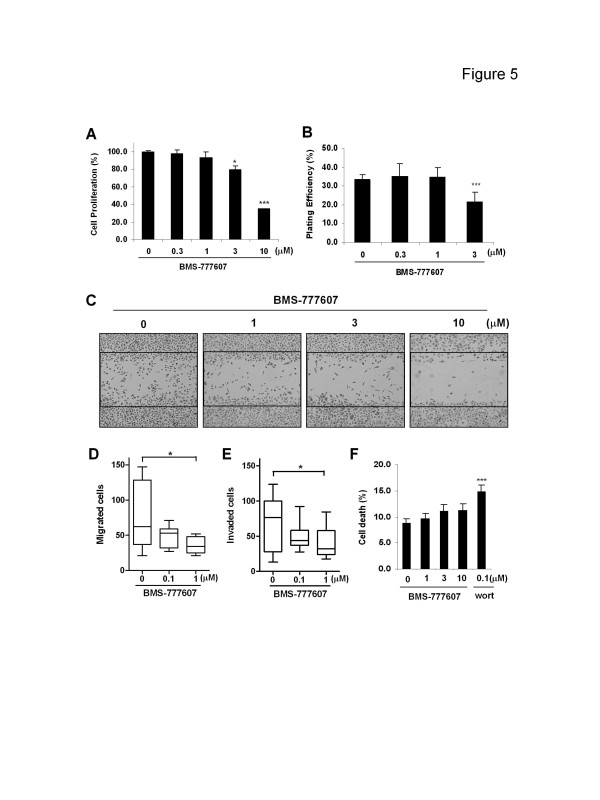
Effect of Met inhibitor BMS-777607 on PC-3 cell functions PC-3 cells were treated with indicated doses of BMS-777607 for 4 days (A), 14 days (B), 1 day (C), 2 days (D, E) and 3 days (F), for the detection of cell growth (MTT assay, A), clonogenicity (colony formation assay, B), cell motility [“wound-healing” assay, C (magnification, ×5)], migration (transwell assay, D), invasion (transwell assay, E) and anoikis (trypan blue exclusion assay, F), respectively. Data either represent 1 of 3 independent experiments (B, C) or are from > 3 independent experiments (A, D, E, F). A, B, F: Columns, mean; bars, SD (n≥9). D, E: boxes, median (middle line) with 75th (upper boundary) and 25th (lower boundary) percentiles; whiskers, 90th (upper) and 10th (lower) percentiles (n = 8). *, P < 0.05 (t-test in A and Wilcoxon test in D, E); ***, P < 0.001 (t-test in A, B, F). Wort = Wortmannin.